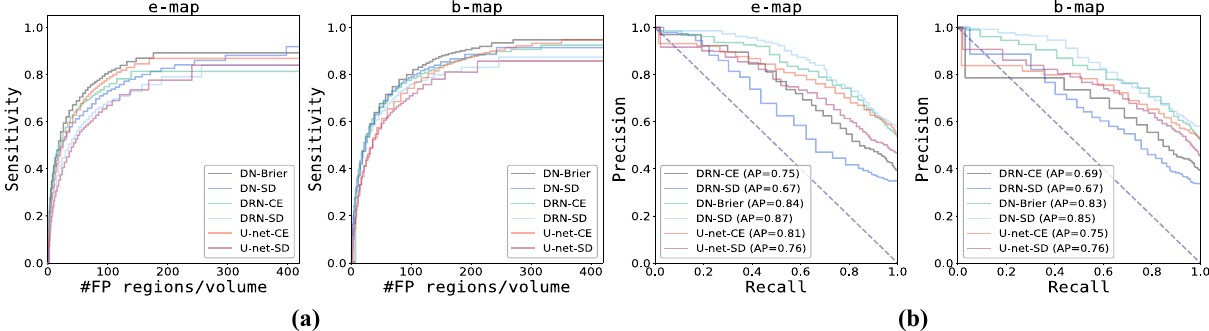
Figure 3. Detection performance of segmentation failures generated by different combination of segmentation architectures and loss functions. (a) Sensitivity for detection of segmentation failures on voxel level (y-axis) as a function of number of false positive image regions (x-axis). (b) Precision-recall curve for detection of slices containing segmentation failures (where AP denotes average precision). Results are split between entropy and Bayesian uncertainty maps. Each figure contains a curve for the six possible combination of models (three) and loss functions (two). SD denotes soft-Dice and CE cross-entropy, respectively.